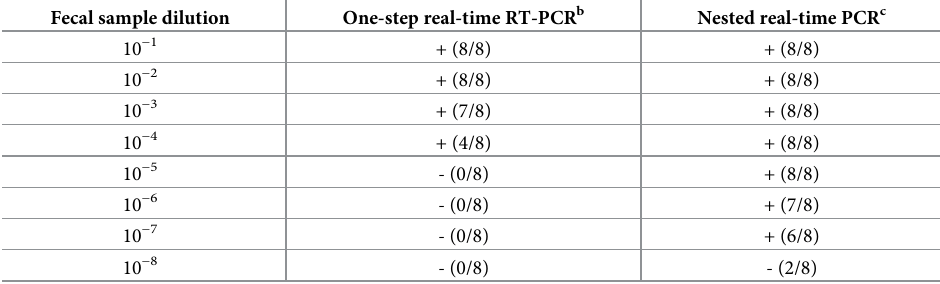
Table 3. Performance comparison of a one-step real-time RT-PCR and a nested real-time PCR for detection of GII.2 norovirus in fecal samples when DIG-labeled hybridization is used for amplicon confirmation a